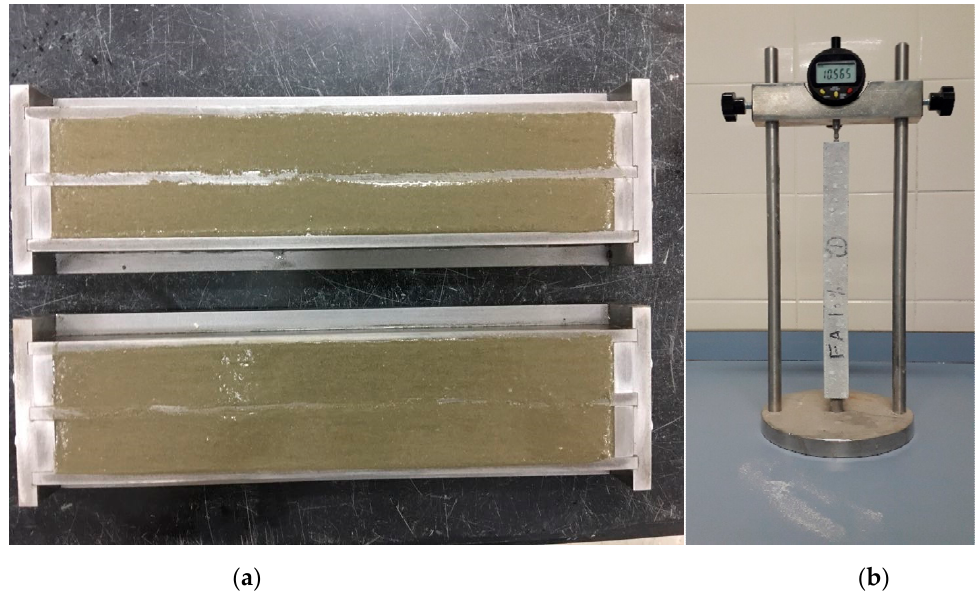
Figure 5. ( a ) Mortar bars after casting for alkali silica reactivity (ASR) expansion and drying shrinkage, and ( b ) test set up to measure length change by comparator for ASR expansion and drying shrinkage.